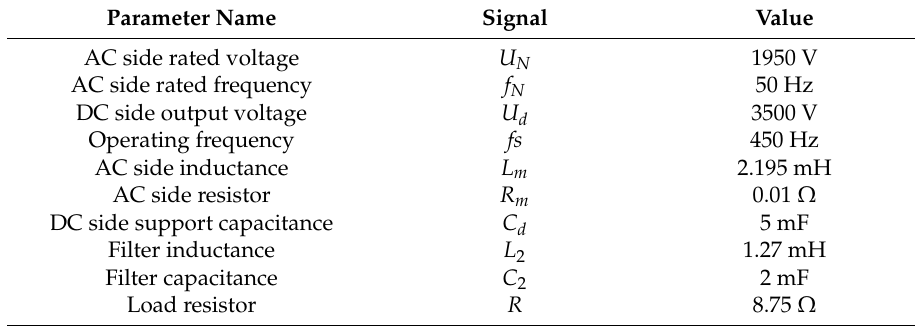
Table 2. Design parameters of locomotive four quadrant converter of China Railway High-speed 2 (CRH2).